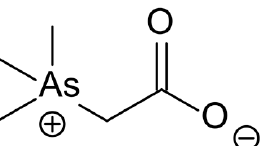
Figure 1. Chemical structure of Arsenobetaine (AB).